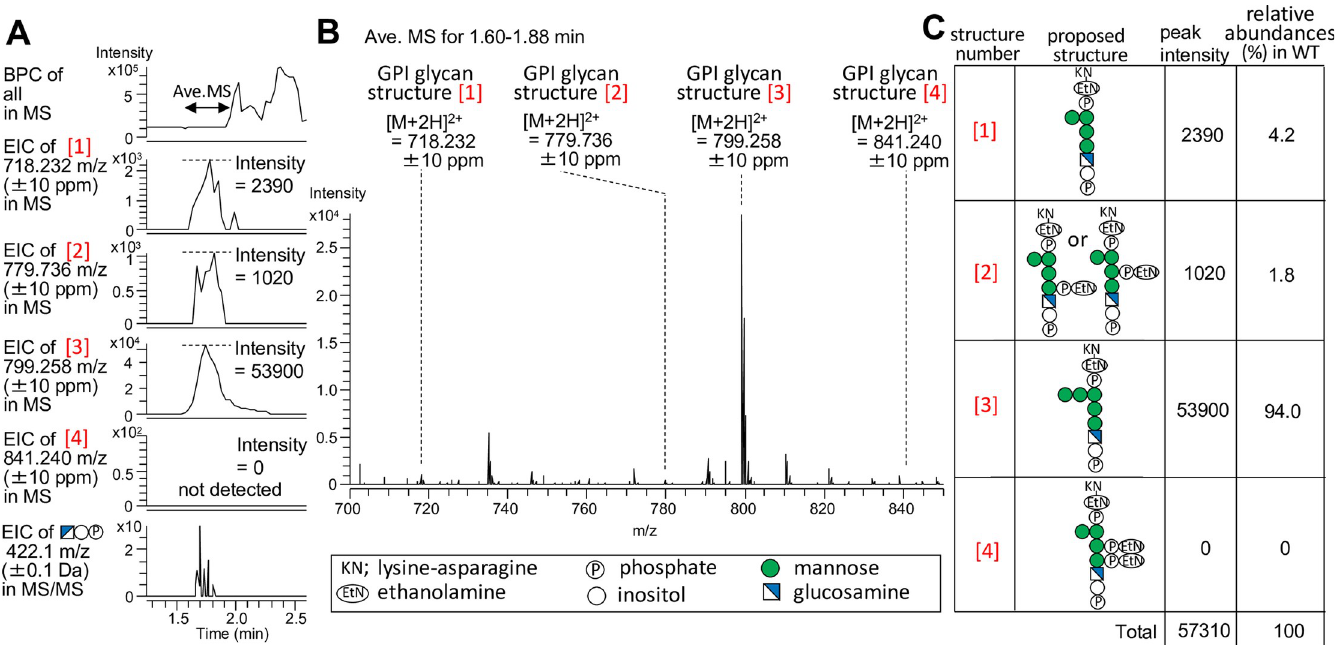
Fig 2. MS analysis of remodeled GPI-glycan structure of Gas1-GFP. (A) The base peak chromatogram (BPC) and the extracted ion chromatograms (EICs) of GPI glycan found in Gas1-GFP immunoprecipitated from wild-type. The bottom panel is EIC of a GPI-specific fragment ion treated with PI-PLC (m/z 422.1, GlcN-Ino-P) in MS/MS. (B) The averaged mass spectra (Ave. MS) for 1.60 to 1.88 min on BPC. (C) The proposed structures and the relative abundances (%) of the GPI glycan found in Gas1-GFP immunoprecipitated from wild-type. The relative abundance (%) of each GPI glycan was calculated from the peak intensity of monoisotopic masses of each GPI glycan in EIC using Xcalibur software ver. 2.2. (Thermo Fisher Scientific). These structures contain GPI peptides (KN) bearing hexosamine (glucosamine) attached to Man1 as reported previously [6].